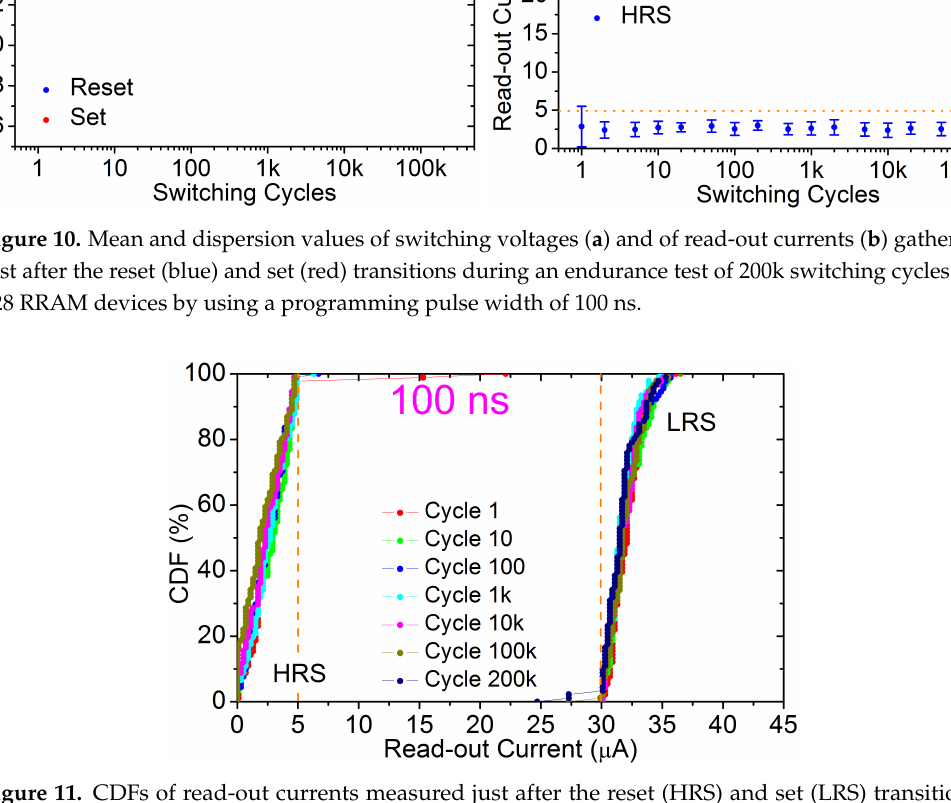
Figure 11. CDFs of read-out currents measured just after the reset (HRS) and set (LRS) transitions during an endurance test of 200k switching cycles on 128 RRAM devices by using a programming pulse width of 100